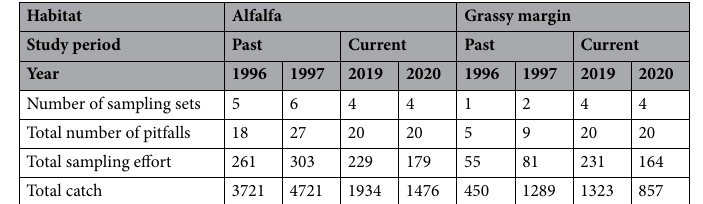
Table 1. Sampling effort data by habitat, study period and year. Data from a fortnightly sample in a pitfall or data of a suction sampling transect of a total area of 0.1 m 2 are treated as equivalent units of sampling effort.